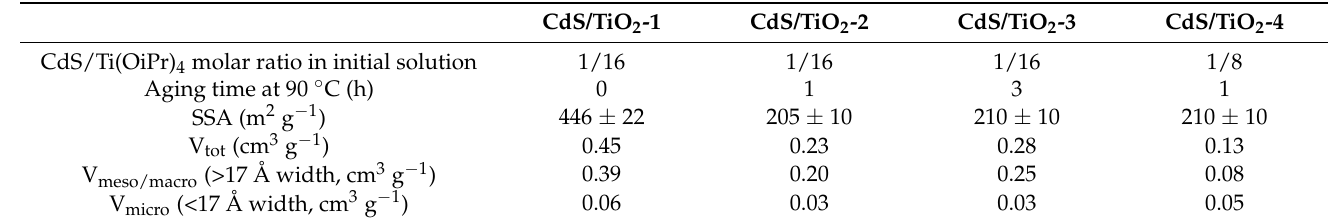
Table 1. Morphological features and preparation details of CdS/TiO 2 -(1–4)